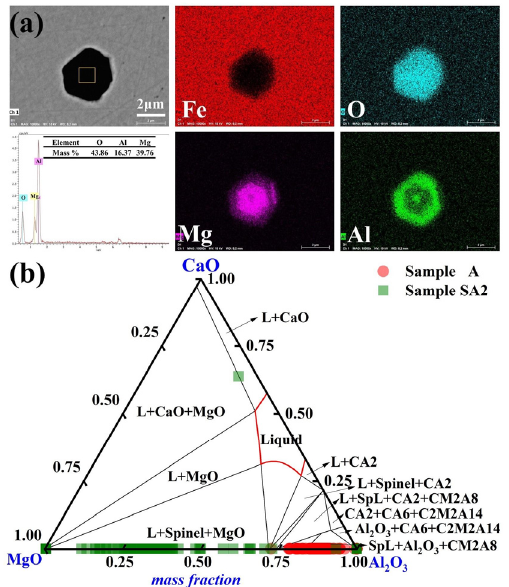
Figure 5. Common inclusions in Sample A2 had the following morphology and composition: ( a ) elemental distribution of the point inclusions and ( b ) composition distributions of the inclusions in Samples A and A2 in the MgO-Al 2 O 3 -CaO phase diagram. At 1600 ◦ C, the solid lines depict the boundaries between several